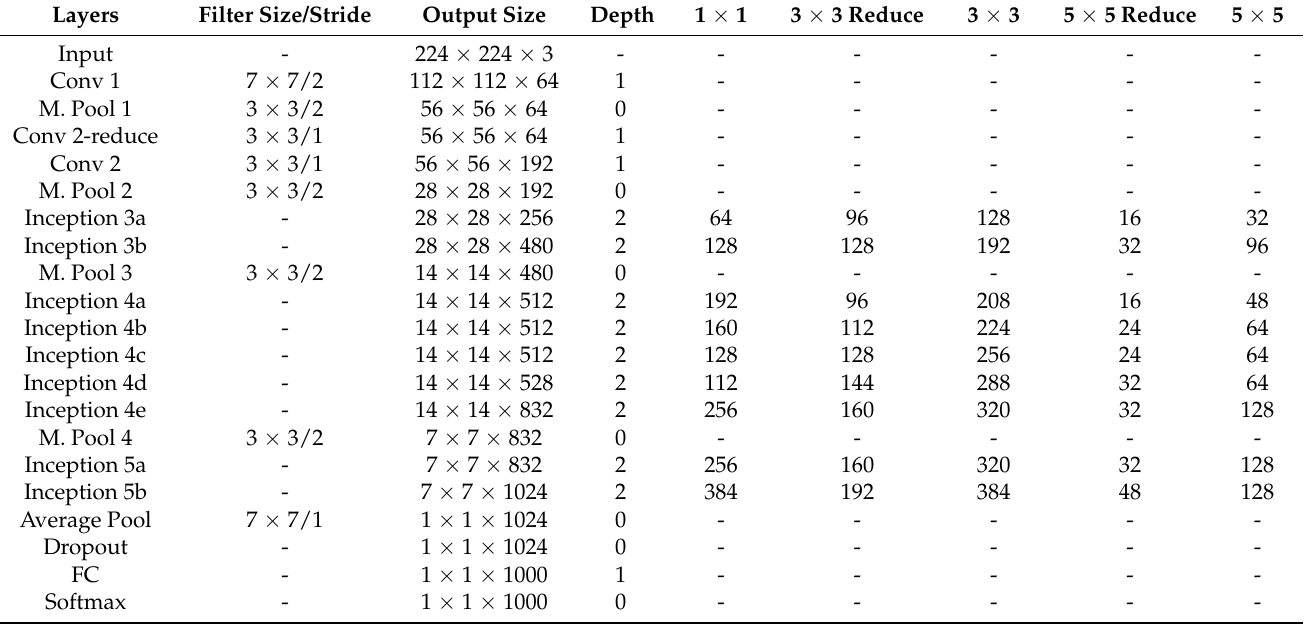
Table 1. The details of the pre-trained GoogLeNet structure.